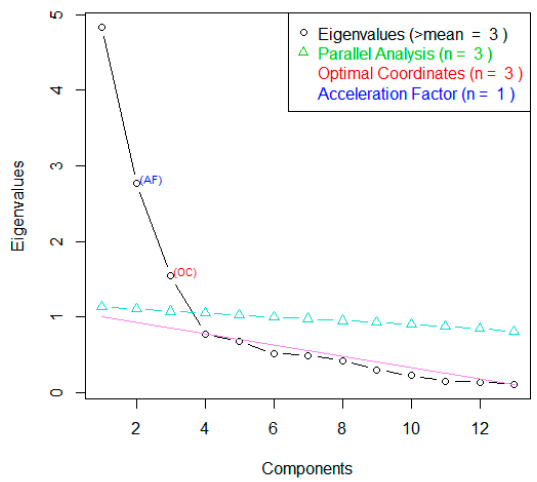
Figure 4. Scree Plot for Factor Analysis of Fixed Term Descriptors applied by a panel of 16 students on 80 images of calves ( n = 20) during a calf roping event.